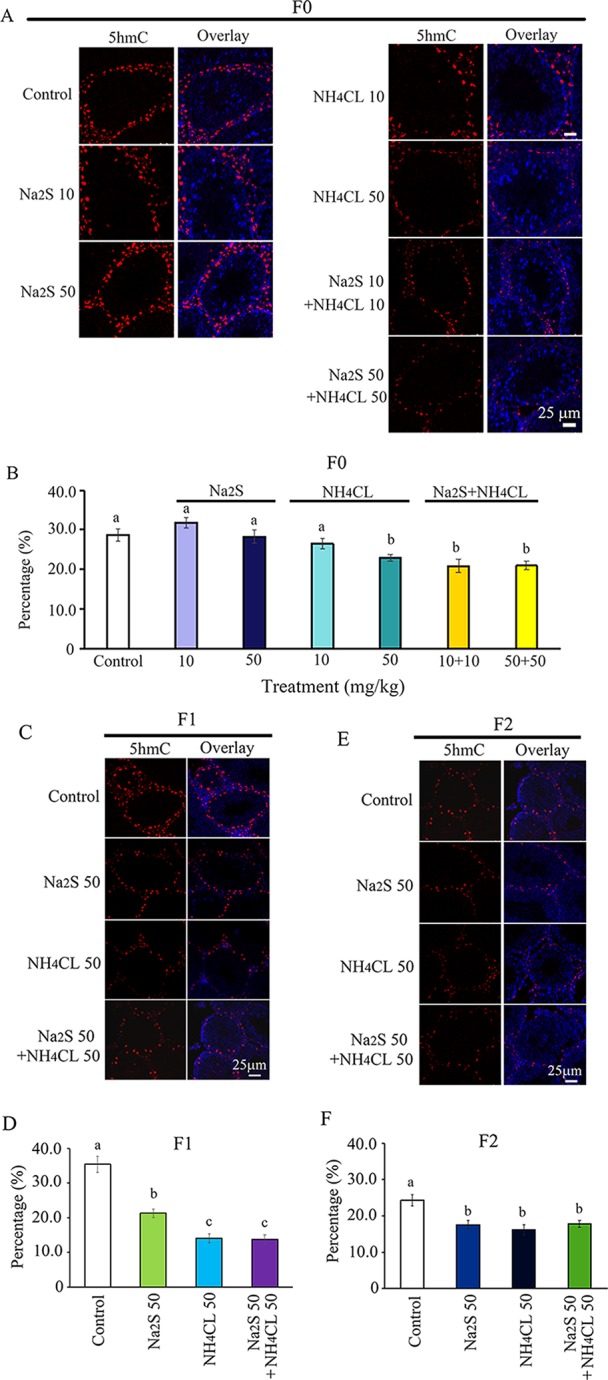
Protein 5hmC in mouse testicular tissue as detected by immunofluorescence staining. (A) 5hmC staining in F0 mouse testis. (B) Quantitative data for 5hmC in F0 mouse testis. (C) 5hmC staining in F1 mouse testis. (D) Quantitative data for 5hmC in F1 mouse testis. (E) 5hmC staining in F2 mouse testis. (F) Quantitative data for 5hmC in F2 mouse testis. N > 6. a, b, c indicate a significant difference among different treatments (p < 0.05).